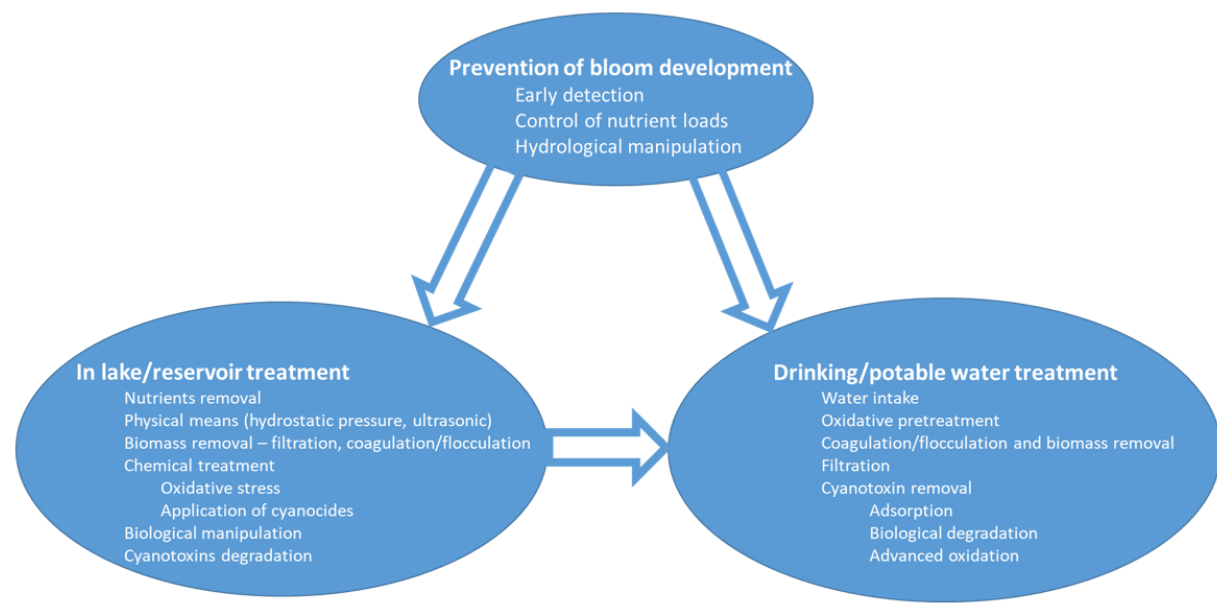
Figure 1. Schematic presentation of strategies and techniques implemented to prevent the development of cyanoHAB and to mitigate potential impacts on aquatic ecosystem and potable water.